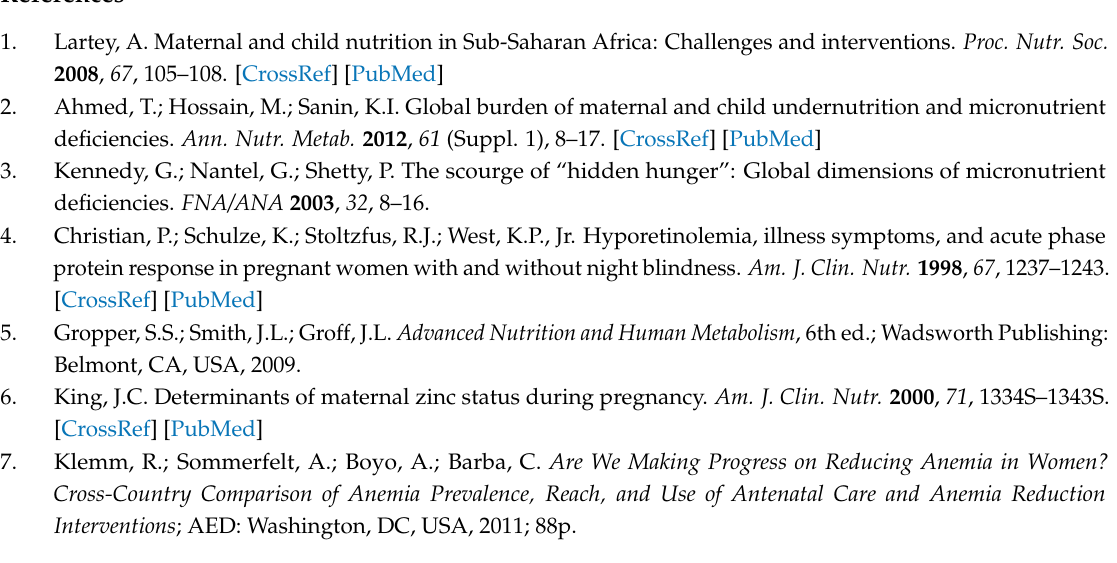
Figure S1: Participant Flowchart, Table S1: Assays used for analysis of nutrients and